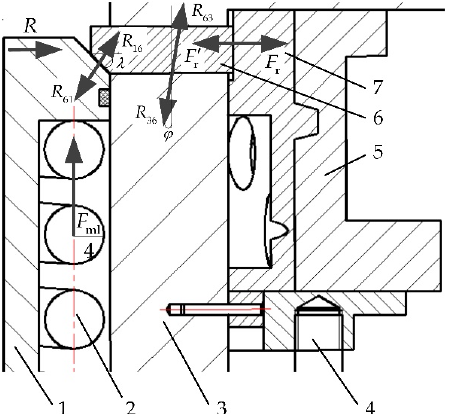
Figure 3. The force analysis of the spring support cylinder and single locking tab in the holding process. 1—Spring support cylinder, 2—Closing spring, 3—Actuator working cavity, 4—Electromagnet, 5—Locking ring sleeve, 6—Locking tab, 7—Locking